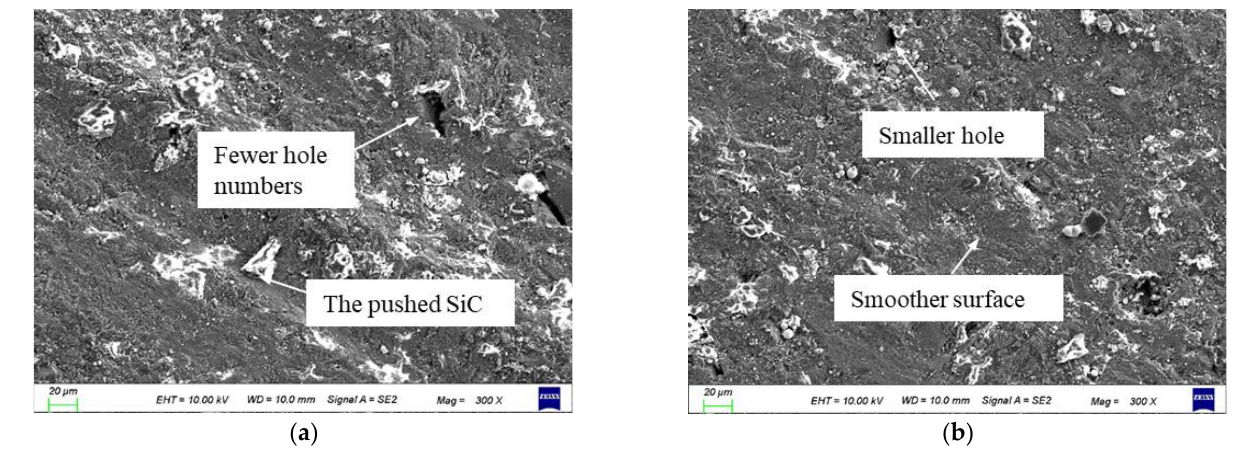
Figure 11. Surface SEM diagrams of different amplitudes: ( a ) No. 2 in Table 3 and ( b ) No. 9 in Ta- ble 3.